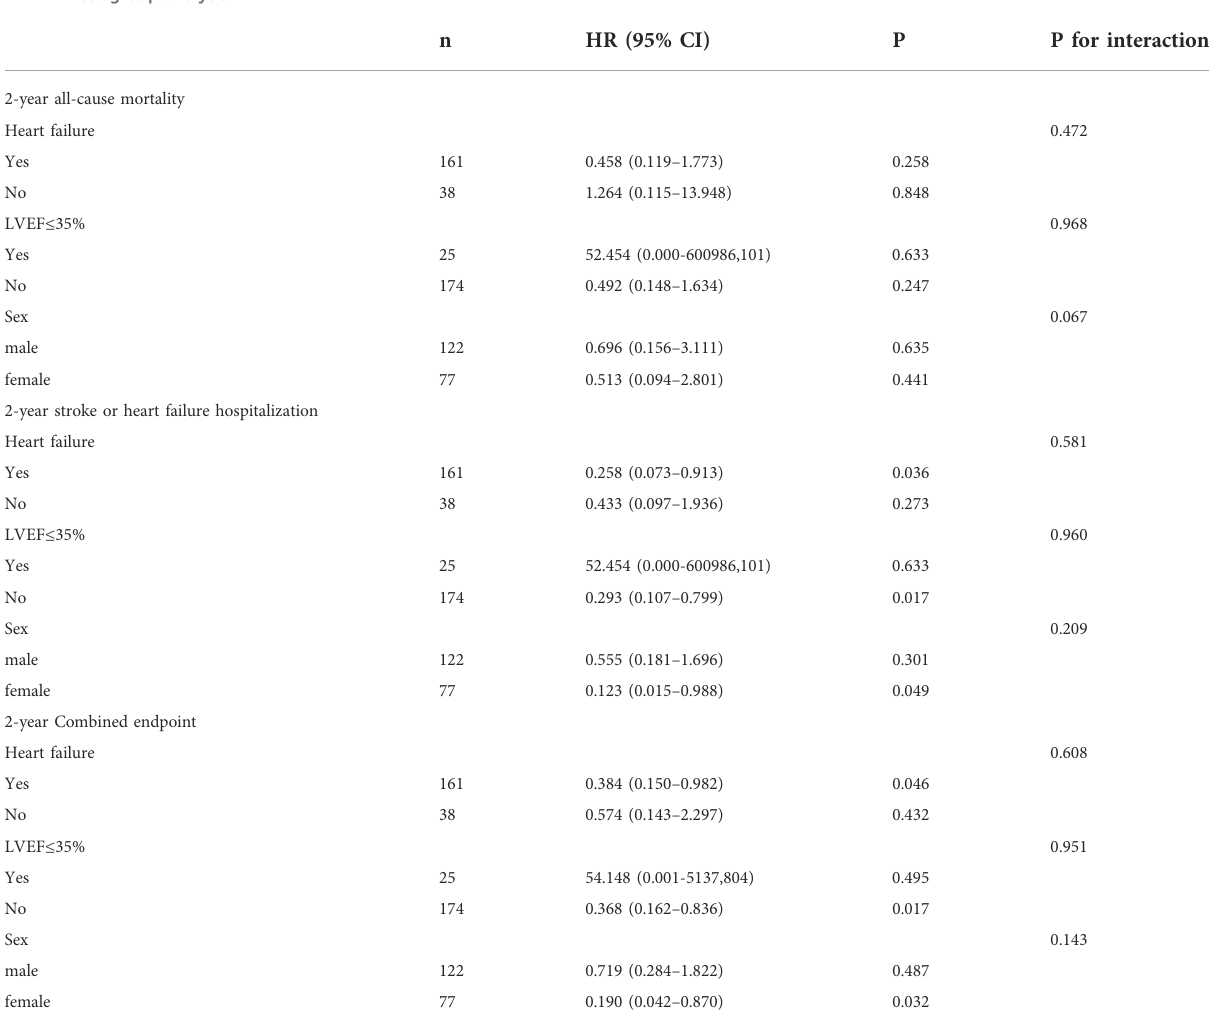
TABLE 4 Subgroup